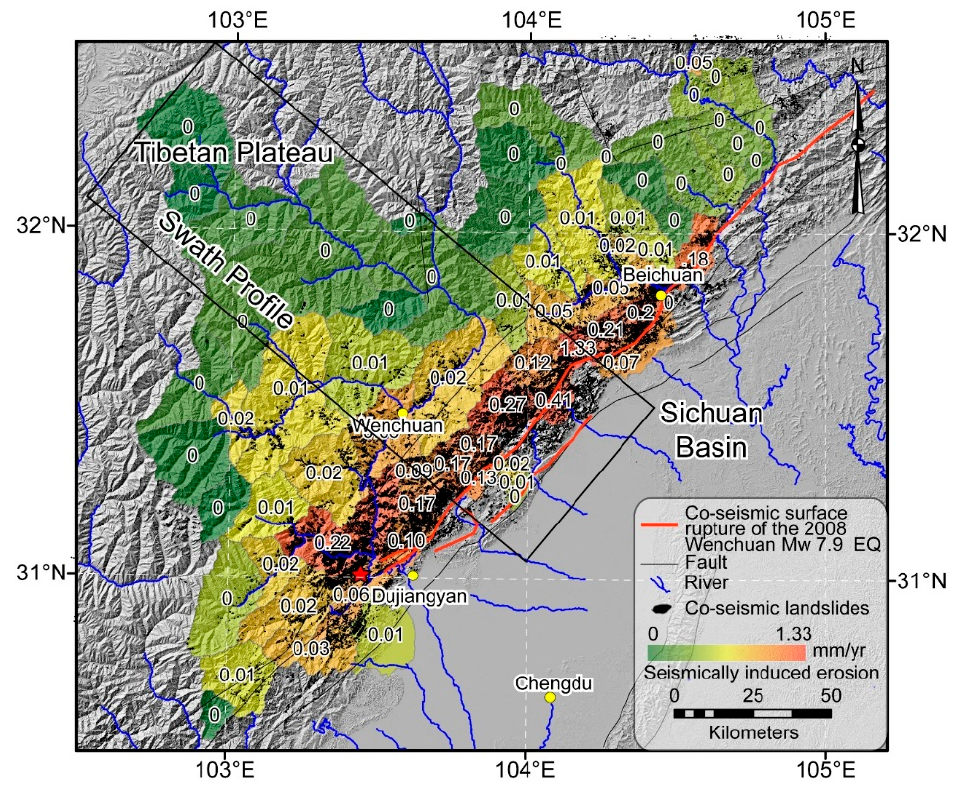
Figure 4. The seismically-induced erosion rates within each catchment in the Longmen Shan region. Erosion rates are calculated using the summed landslide volumes within each catchment. Table 2. Seismically-induced erosion rates calculated using the differential DEM method within each catchment shown in Figure 3.